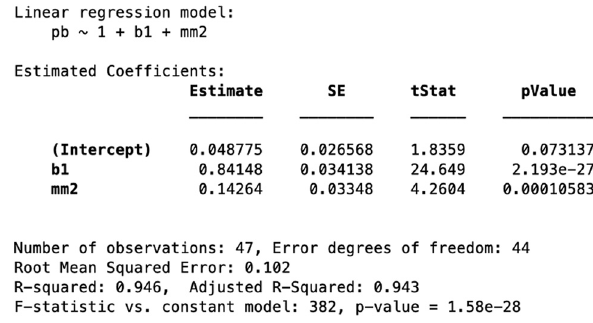
Figure 6: Final tenfold cross - validated and stepwise - improved linear regression for the trustee. b1 is the trustee ’ s SPE and mm2 is the trustee ’ s strategy to help the weakest player.